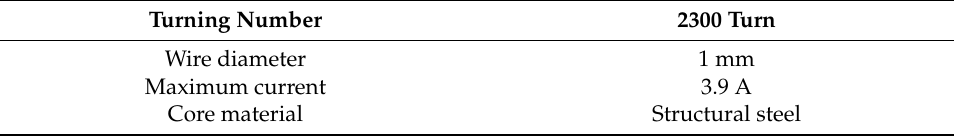
Table 2. Common parameters for magnetic coil.